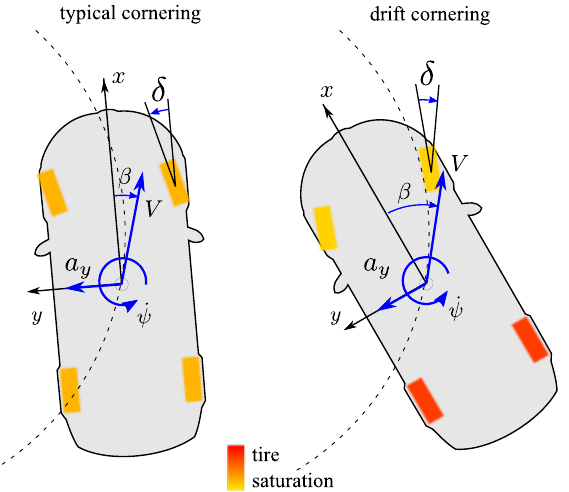
Figure 1. Typical cornering vs. drift